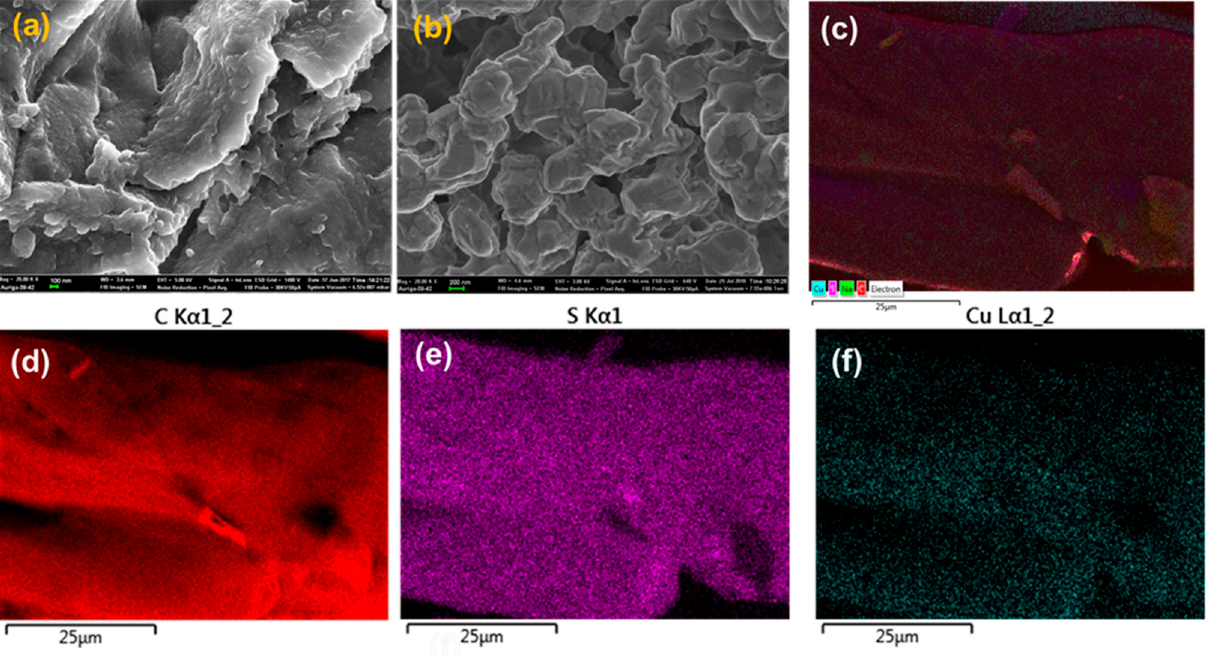
Figure 1. FE-SEM micrographs of ( a ) TFSA and ( b ) Cu@TFSA; with elemental mapping of ( c ) Cu, S, C, ( d ) C, ( e ) S, and ( f ) Cu.